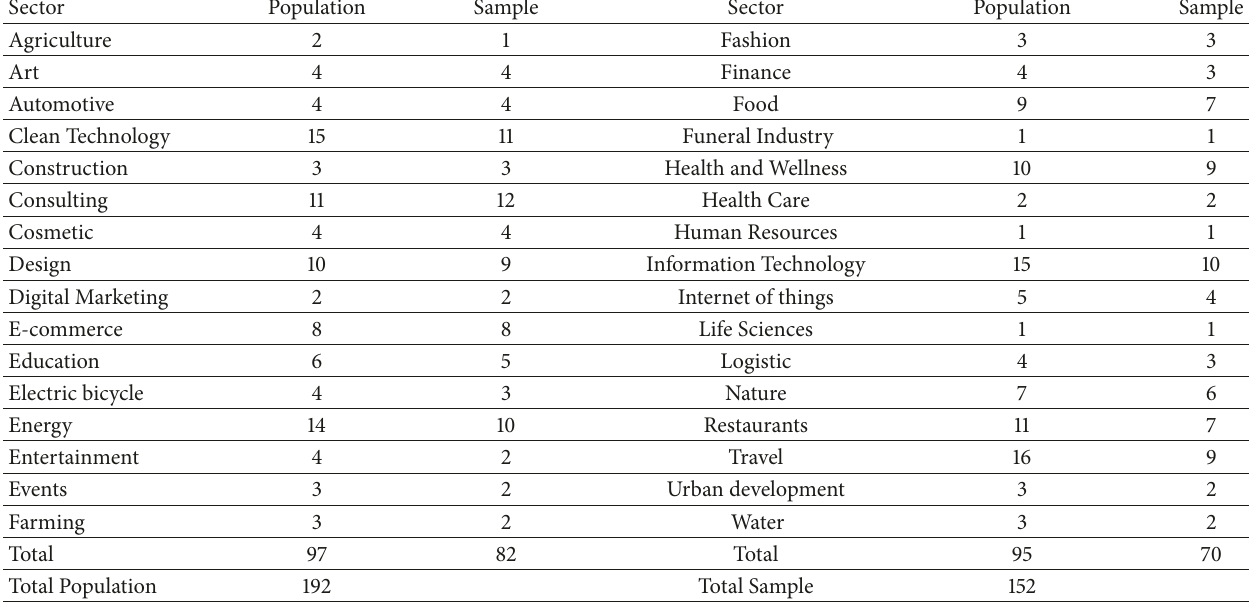
Table 1: Online environmental startups in